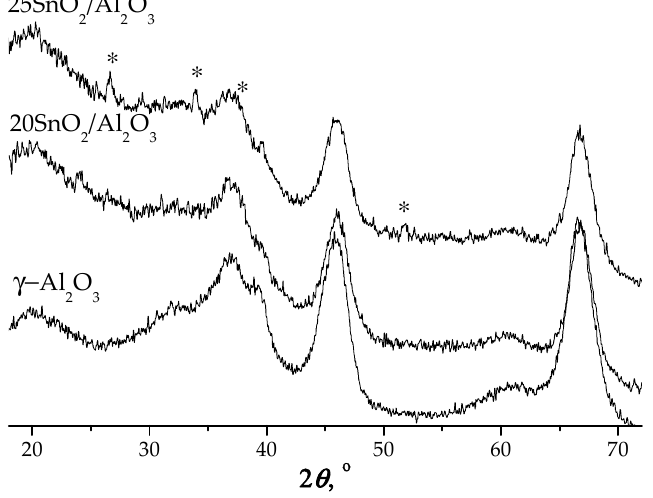
Figure 2. DFT pore-size distributions of samples calcined at 550 °C.